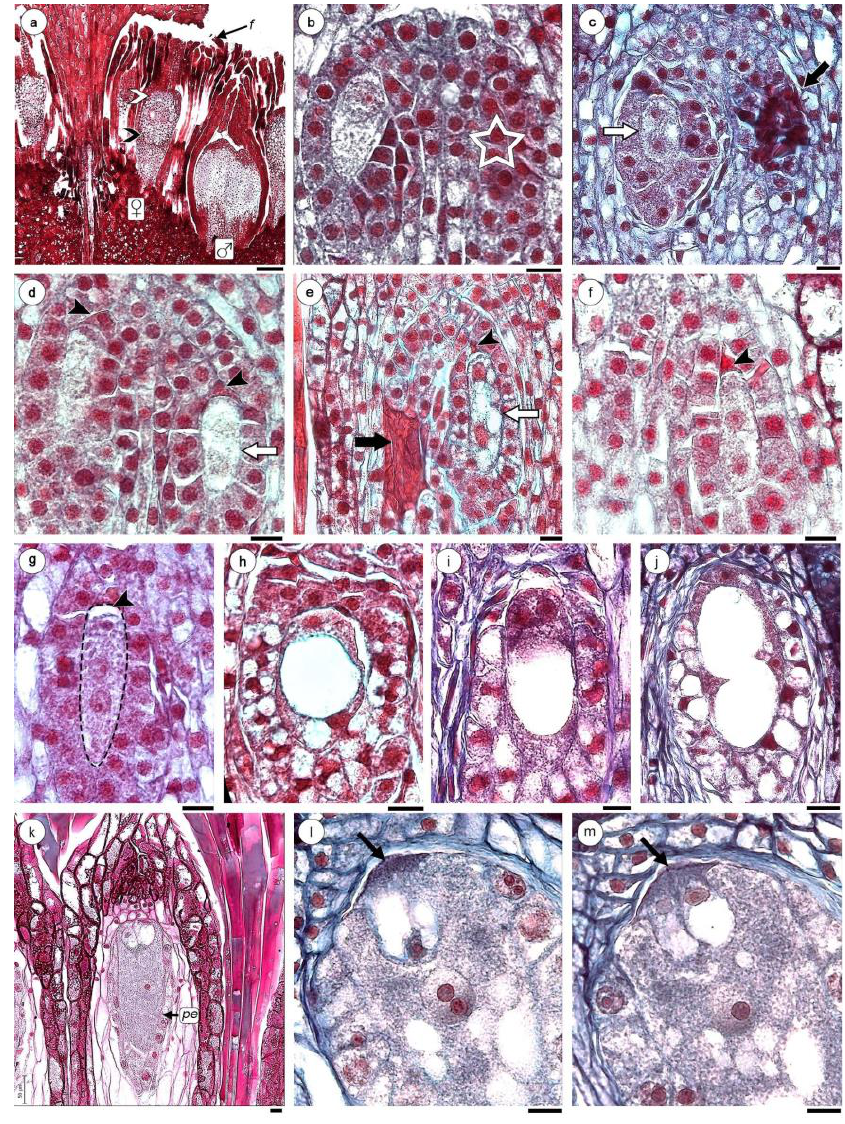
Figure 4. Female gametophyte development of H. cayennensis (LM). ( a ) Transection of inflorescence showing male (with microspore mother cells) and female flowers (with MMC), black arrow point indicates “lower” region of the nucellar complex (NC) and white arrow point shows “upper” or distal region of the NC. ( b ) Nucellar complex (NC) with one MMC, the second MMC is not visible in this section, its position is indicated with a star. ( c ) NC with dyad of megaspore (white arrow) and necrotic MMC (black arrow). ( d ) NC with pair of binucleate sporophytes, the apical cell is degenerating (black arrowhead) and basal is in second mitosis (white arrow). ( e ) NC with binucleate and vacuolated sporophytes (white arrow), aborted megaspore (black arrowhead) and necrotic MMC (black arrow). ( f – g ) trinucleate stages, black arrowhead indicates megaspore degenerated. ( h – j ) Gametophyte with 4 nuclei separated by a central vacuole (only two are visible in the sections h – i ). ( k ) Mature gametophyte showing egg apparatus with two synergids, one egg cell and a central cell containing a single nucleus. ( l – m ) Serial sections of oosferic apparatus with filiform apparatus (arrows), ( l ) egg cell and central cell with large nucleus and two nucleoli. ( m ) Longitudinal sections of same embryo sac across synergids. Abbreviations: ♀ : female flowers; ♂ : male flowers; f: filariae; pe: pseudo–endothelium. Scales bar = ( a ) 0.2 mm; ( b – m ) 200 µm.